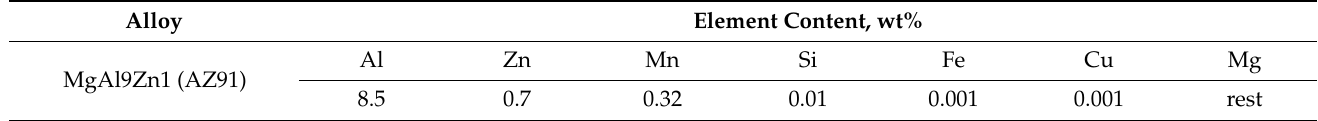
Table 1. Chemical composition of AZ91 magnesium alloy.